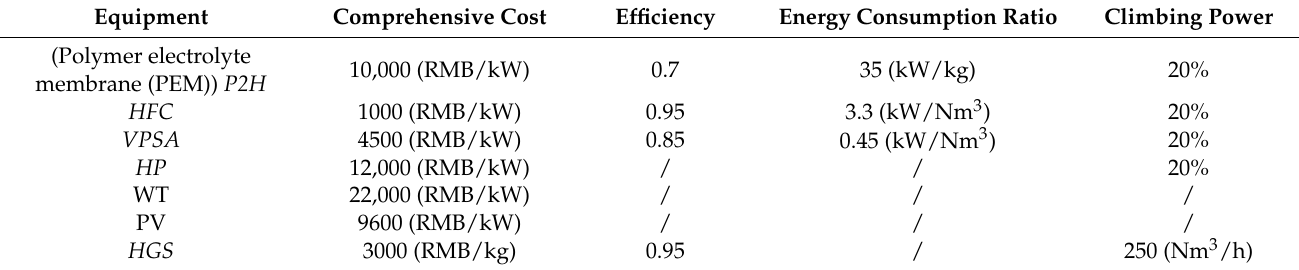
Table 3. Relevant parameters.